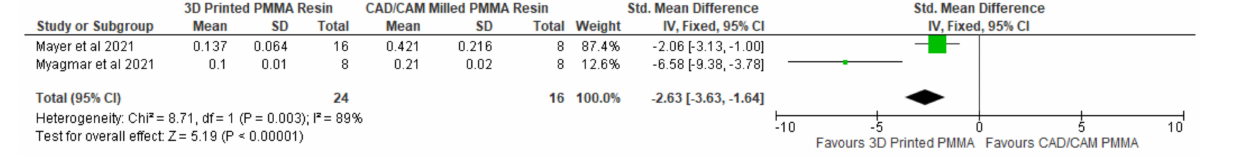
Figure 13. Forest plot comparing wear resistance between 3D-printed PMMA resin and CAD/CAM milled PMMA resin.